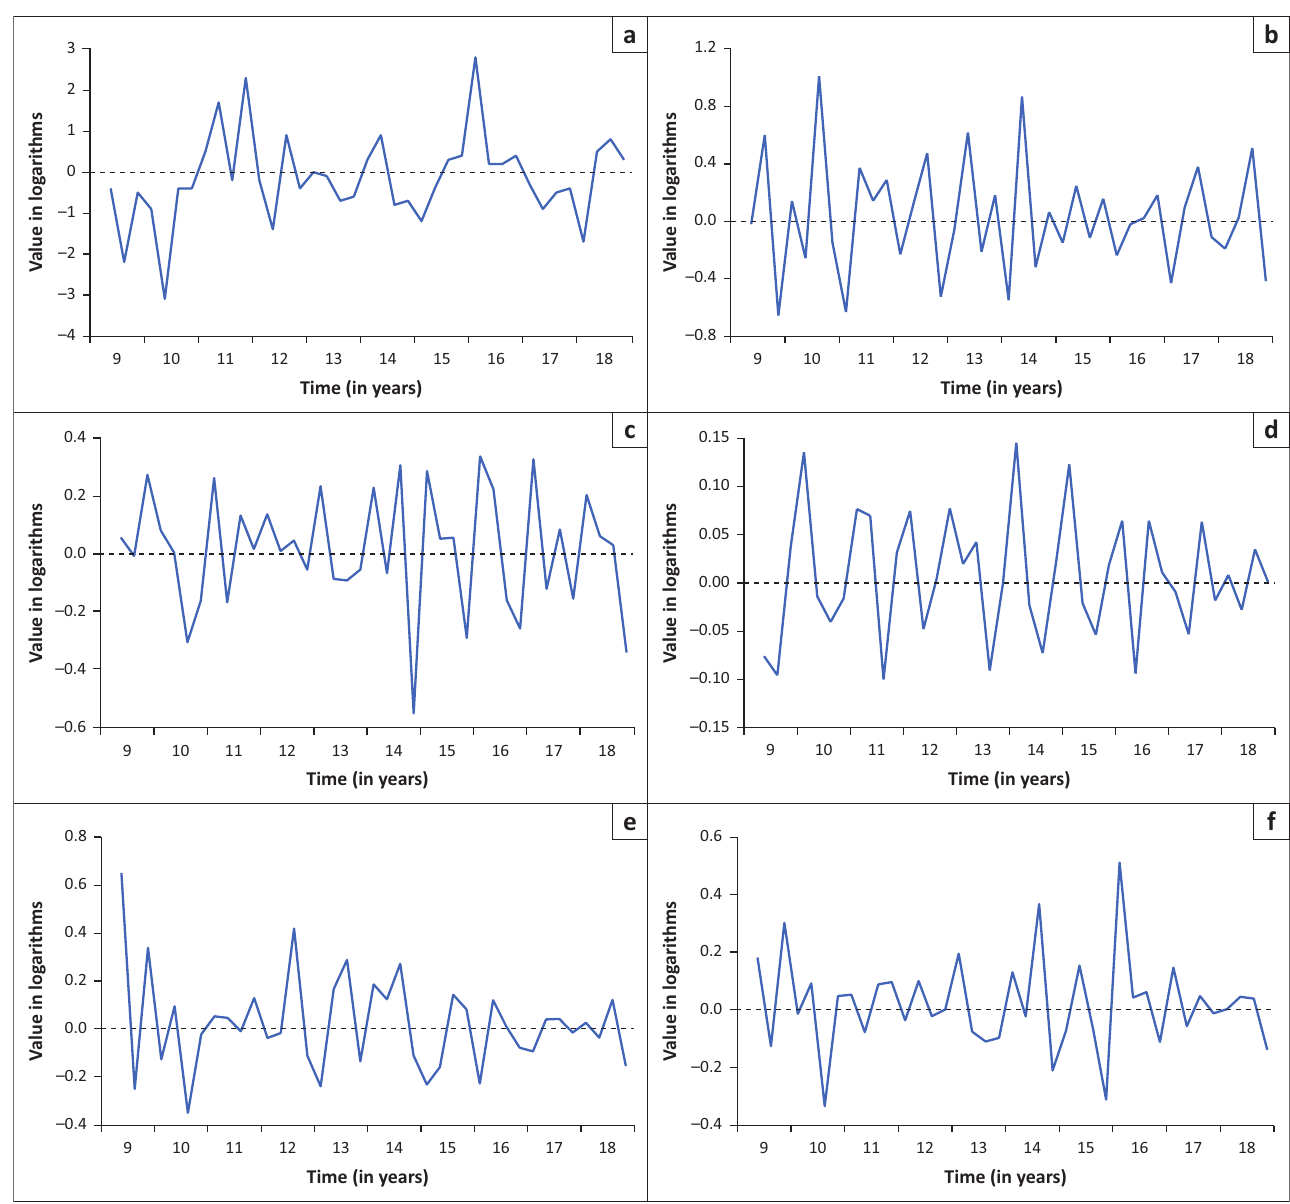
FIGURE 2: Variables in first difference: (a) differenced INF; (b) differenced LDEXT; (c) differenced LFHEXT; (d) differenced LGDP; (e) differenced LIMP; (f) differenced